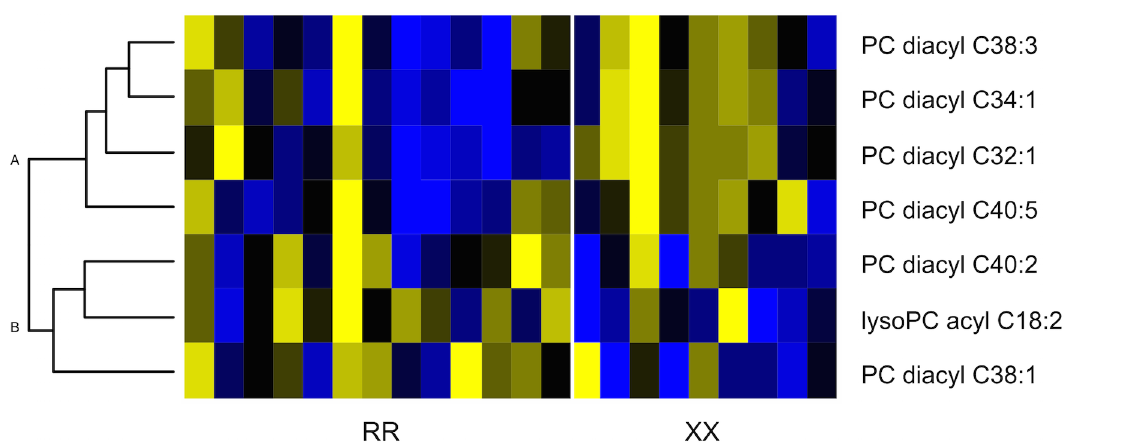
Fig 2. Heatmap and hierarchical clustering of significantly different metabolites stratified by ACTN3 RR vs XX genotype. Yellow blocks represent high concentrations; blue blocks represent low concentrations; black blocks represent medium concentrations.